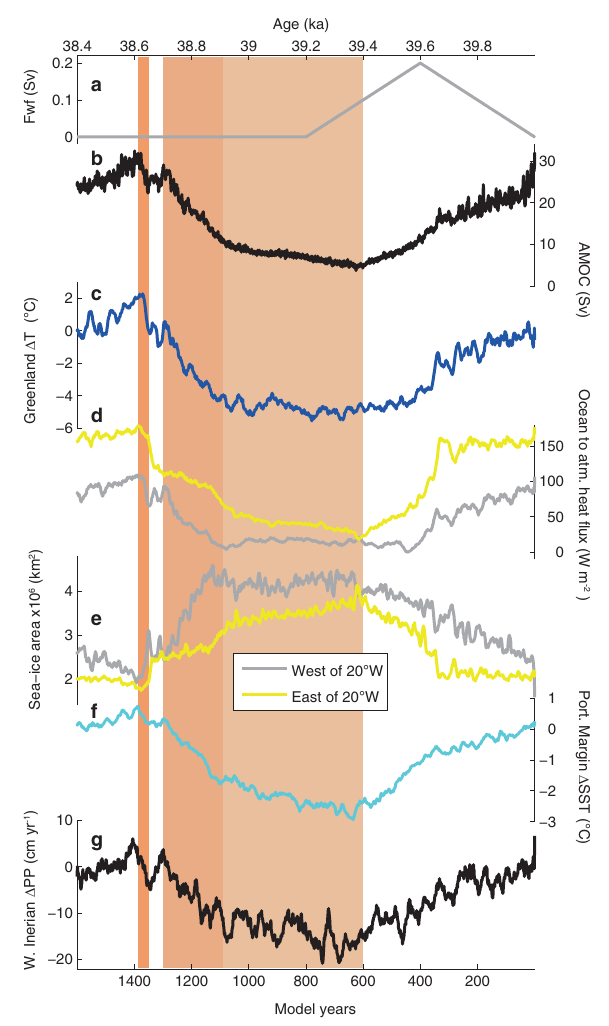
Fig. 6 Timeseries of the numerical experiment of HS4 performed with the Earth system model of intermediate complexity LOVECLIM. a Freshwater input (Sv). b monthly AMOC (Sv) with a 21 month-smoothing. c Annual mean Greenland air temperature anomalies (°C). d Ocean to